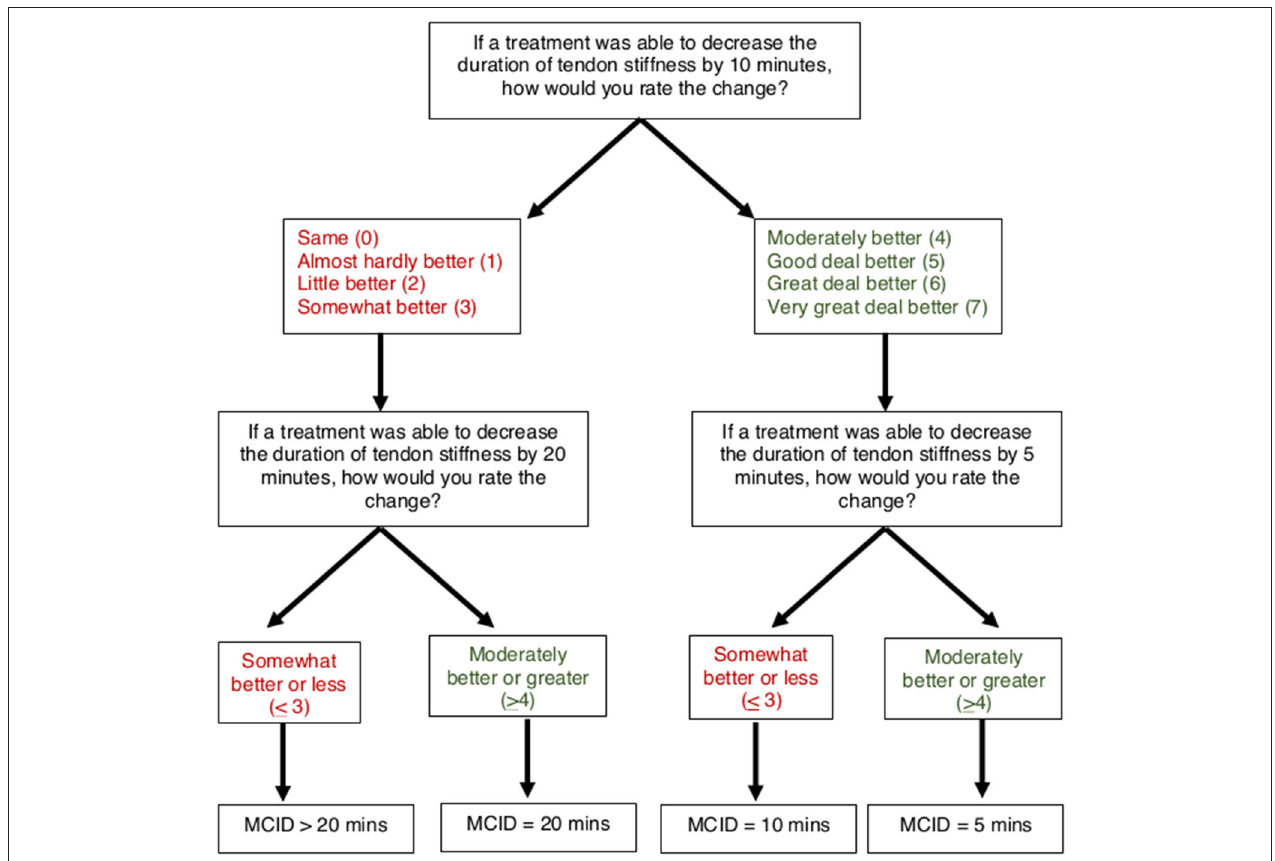
FIGURE 5 | Flow chart for determining patient-driven MCID for Achilles tendon